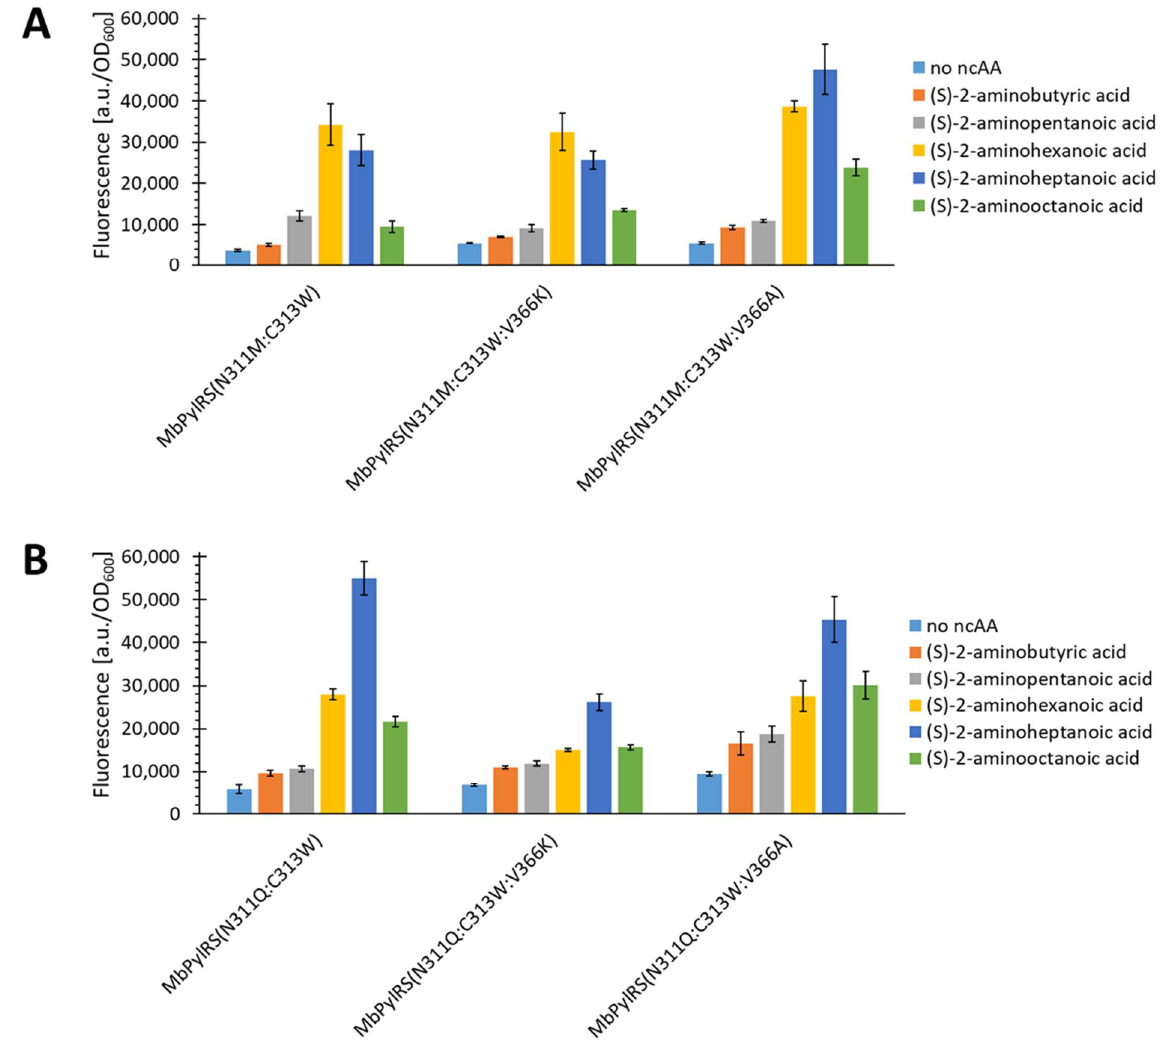
Figure 6. Comparison of aliphatic ncAA incorporation efficiency for ( A ) Mb PylRS(N311M:C313W) and ( B ) Mb PylRS(N311Q:C313W) constructs both mutated at position V366. The fluorescence was measured for intact E. coli BL21(DE3) cells producing the SUMO-sfGFP(R2amber) reporter protein. The data (incl. standard deviation) represent the mean of three biological replicates.